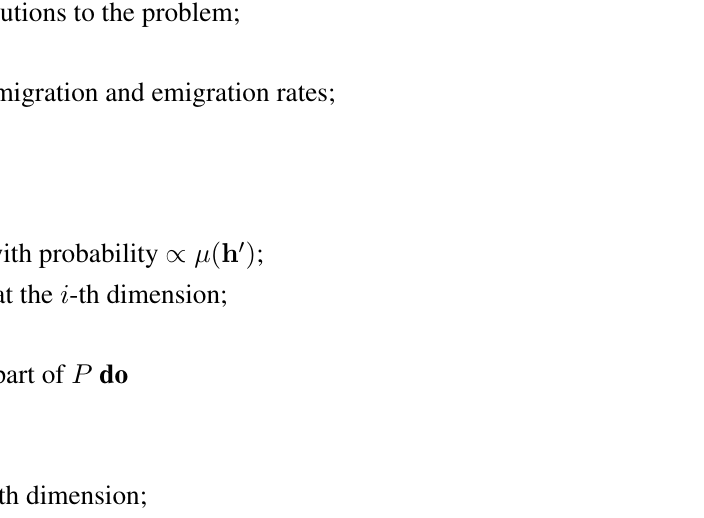
Algorithm 1 The new BBO algorithm for the proposed transportation planning